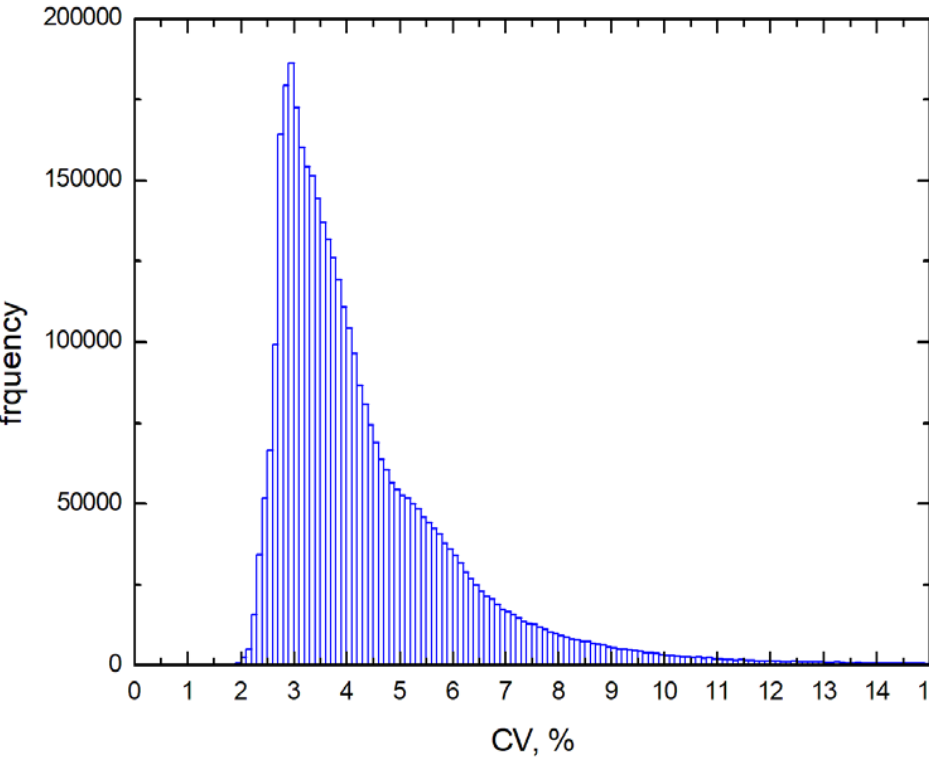
Figure 10. The statistical distribution of the coefficient of variance.